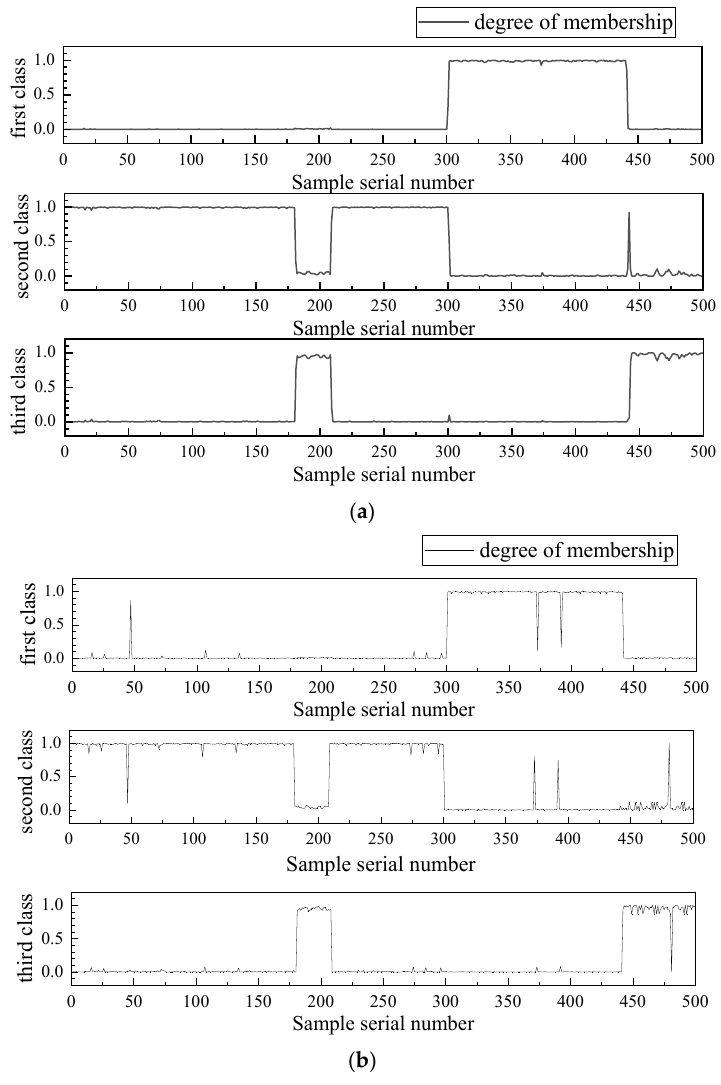
Figure 5. Comparison of the degree of membership graphs of the two methods: ( a ) Local regression FCM; ( b ) FCM. tains samples 181 to 208 and 443 to 500.